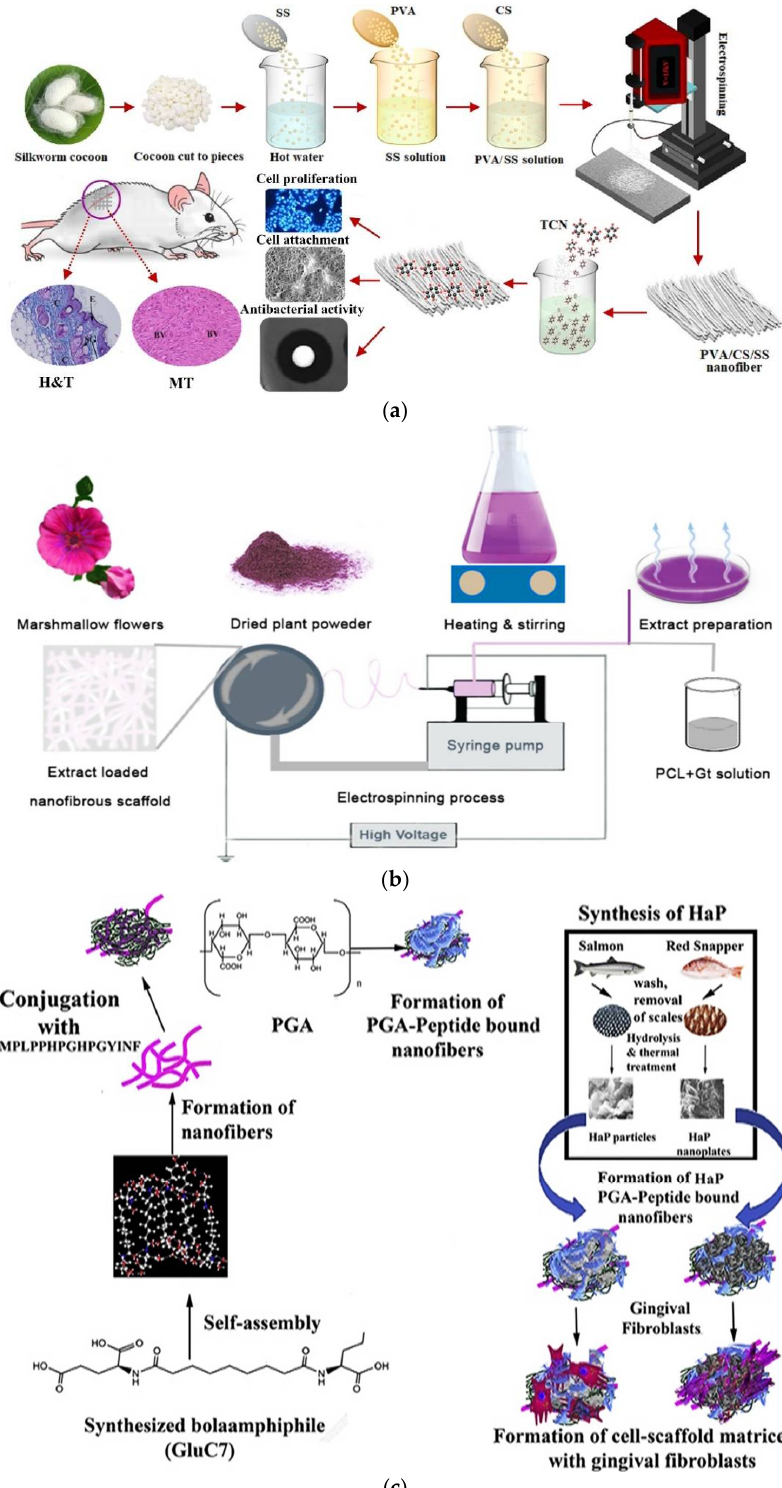
Figure 7. A schematic illustrates the fabrication of ( a ) PVA/CS/SS-TCN electrospun nanofibers (reproduced from [99] with permission of Elsevier, 2020), ( b ) electrospinning process for fabrication of AO extract loaded nanofibrous scaffolds (reproduced from [100] with permission of Wiley, 2019), and ( c ) the synthesis and development of the scaffolds and their interactions with gingival fibroblastsb (reproduced from [101] with permission of Elsevier,